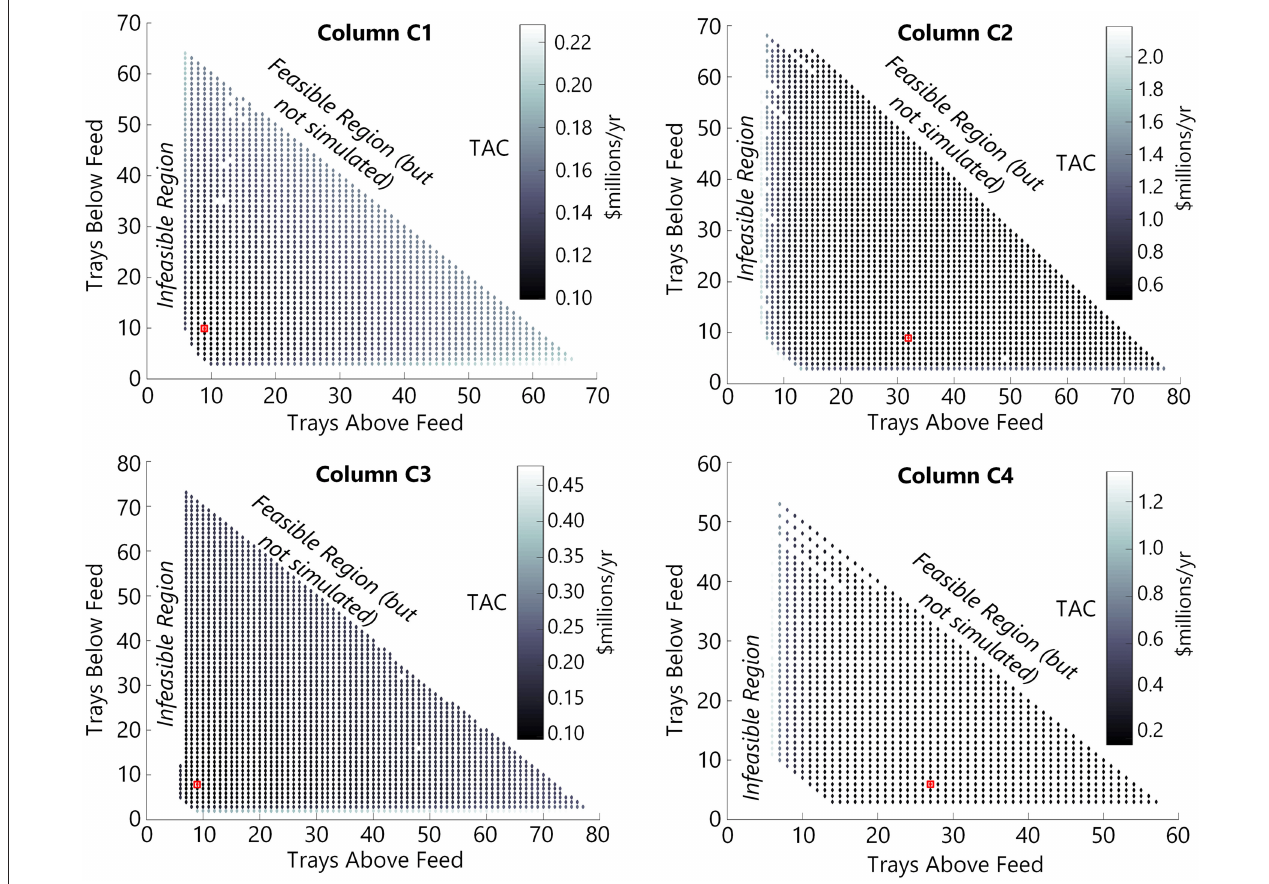
FIGURE 3 | A plot of the expected TAC of each of the four columns ( TAC Exp , C 1 ... TAC Exp , C 4 ) for the Base Case as a function of N A , c , N B , c for φ Exp , D = 0.5. The red square indicates the optimal N A , c , N B , c found after solving Problem